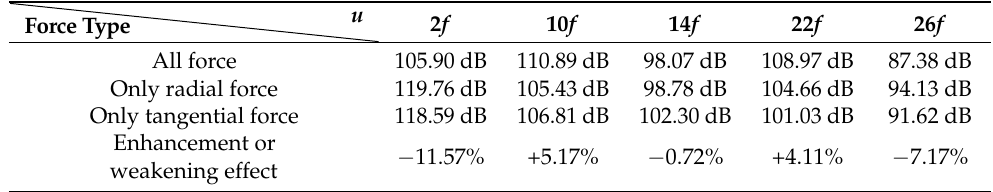
Table 5. Vibration acceleration level of the minimum non-zero spatial order force density under loading operation of a 14-pole 12-slot PMSM.